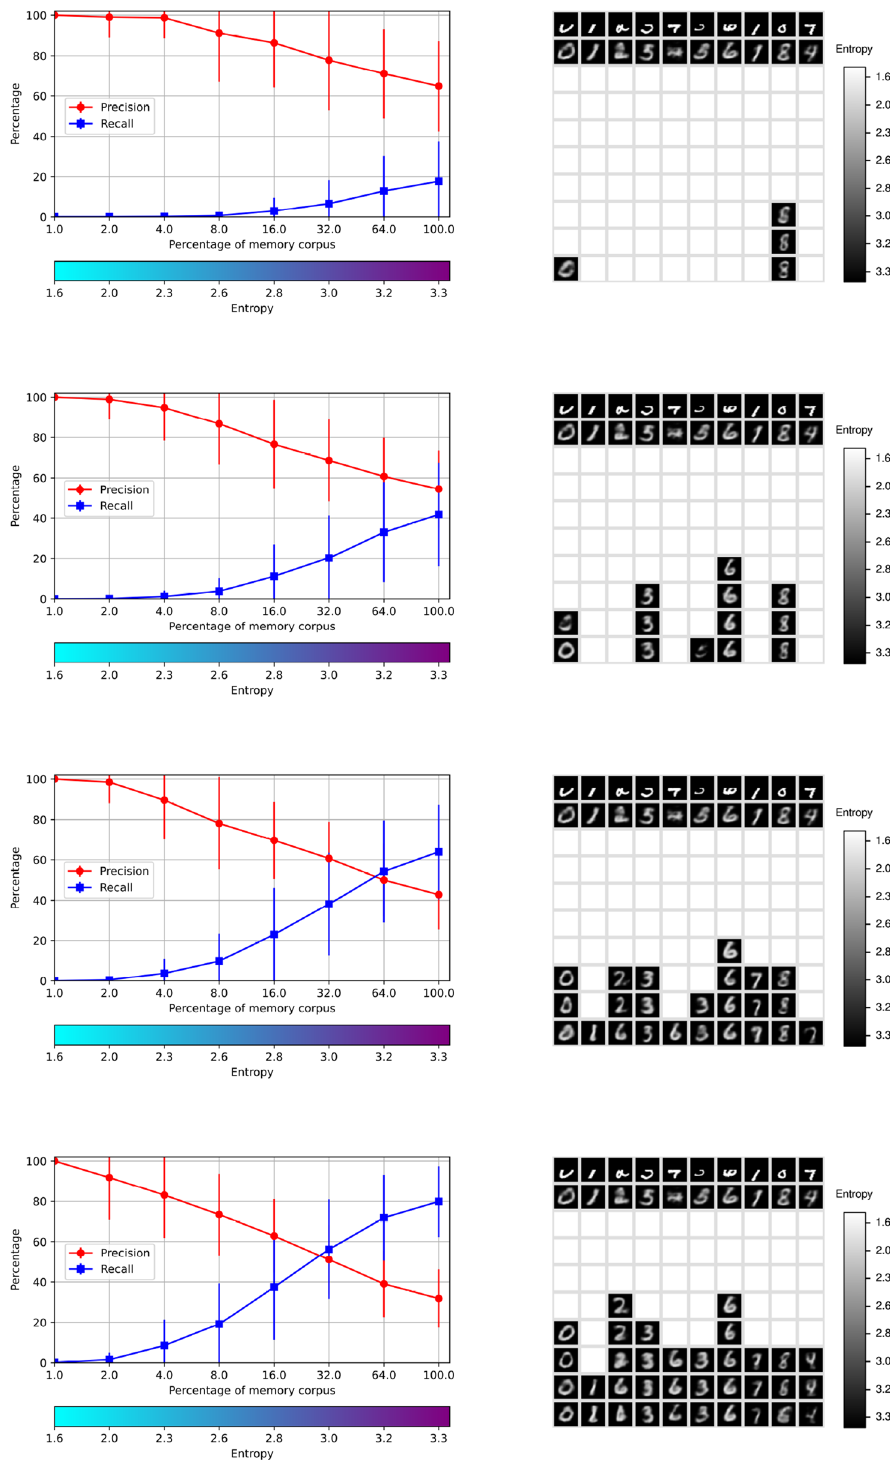
Figure 8. Memory retrieval with occlusions of 50% at the top with relaxations of 1, 2 and 3 features out of